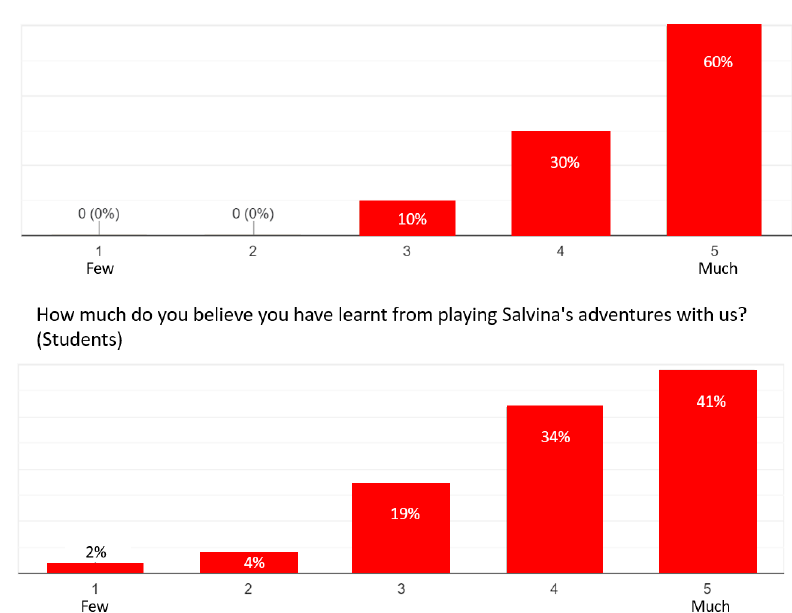
Figure 7. Cumulative values showing percentage of the feedback received for the first question from teachers and students, concerning all the played Salvina’s adventures.